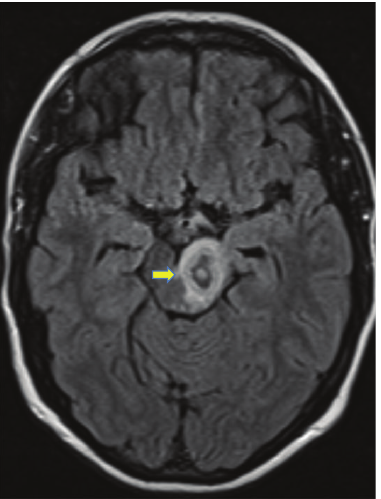
Figure 6: Tuberculoma after 1 month (horizontal view).